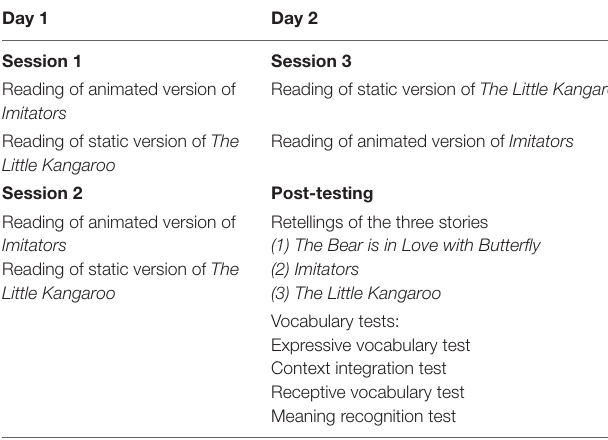
TABLE 1 | An example of the schedule of the experiment.